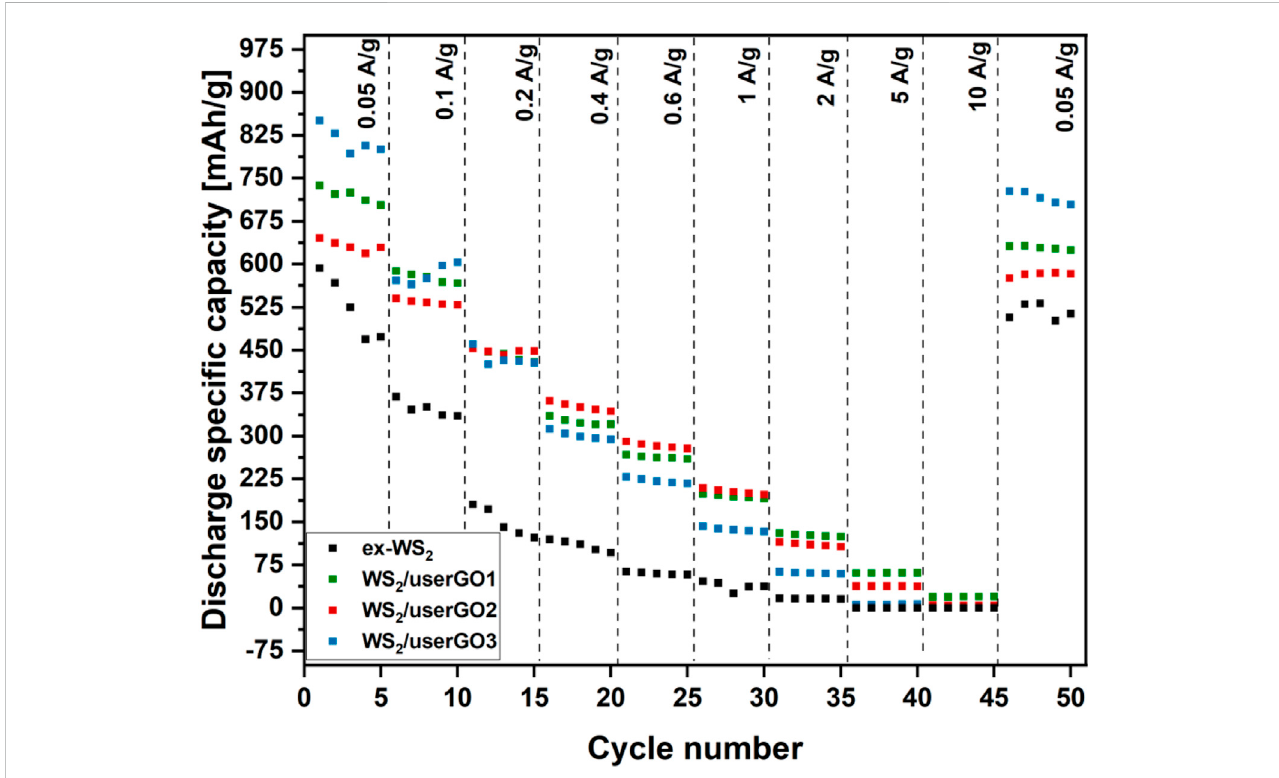
FIGURE 7 Rate performances of WS 2 /userGO1, WS 2 /userGO2, WS 2 /userGO3, and ex-WS 2 electrodes recorded at different current densities.